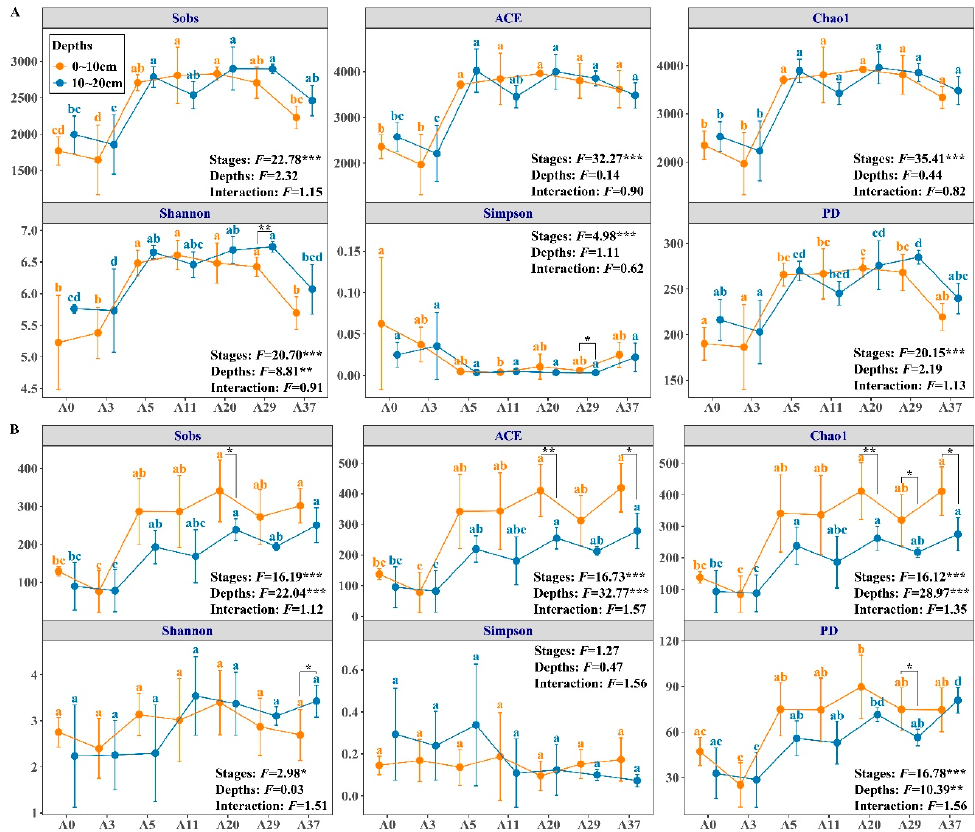
Figure 3. Changes in soil bacterial ( A ) and fungal ( B ) diversity indexes at the two depths during the stages of afforestation by aerial sowing in the northeastern Tengger Desert, China. The difference between the two depths was tested via ANOVA to show the significance level. The multiple compar- isons of means between stages were tested using Tukey’s HSD and represented in lowercase. The multiple ANOVA of the interaction effect of stages, depths, and stages × depths on soil carbon is represented with the F value and significance level, * p < 0.05, ** p < 0.01, *** p < 0.001.